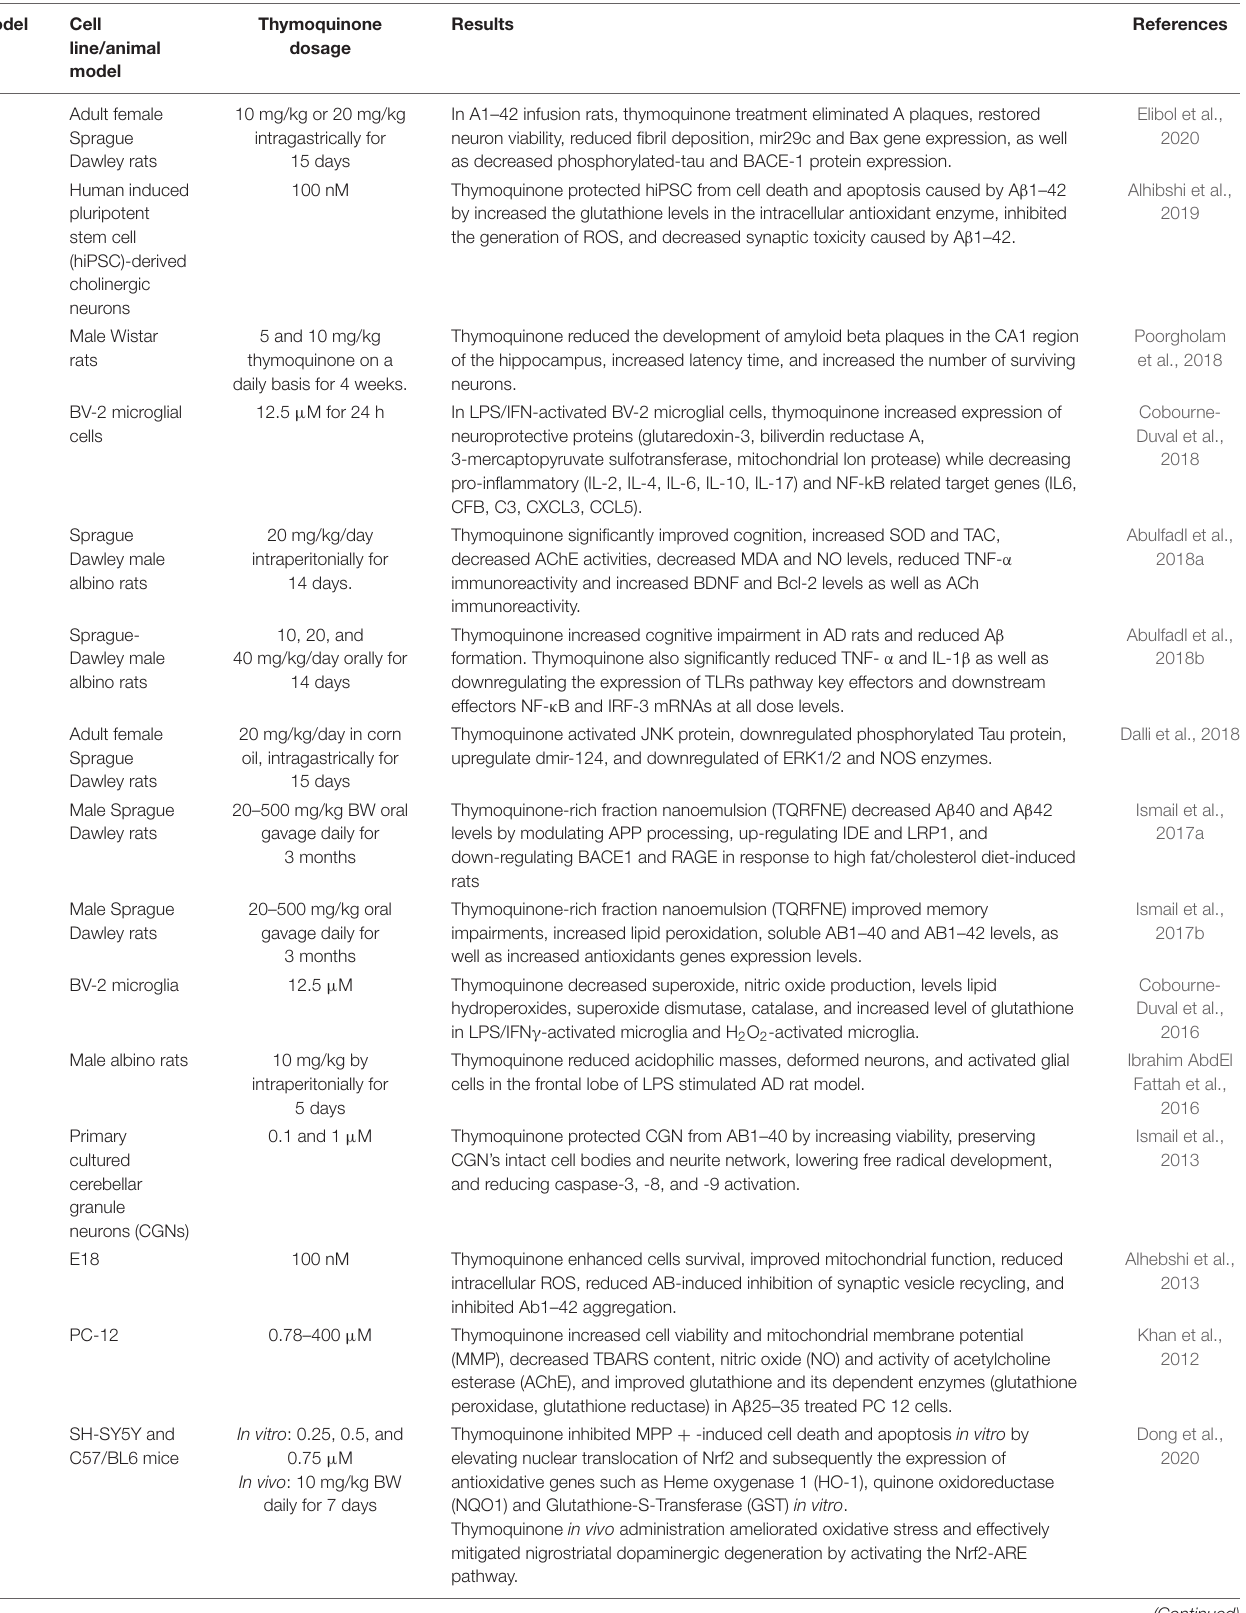
TABLE 1 | In vitro and In vivo studies on the neuroprotective effects of thymoquinone in AD and PD models.